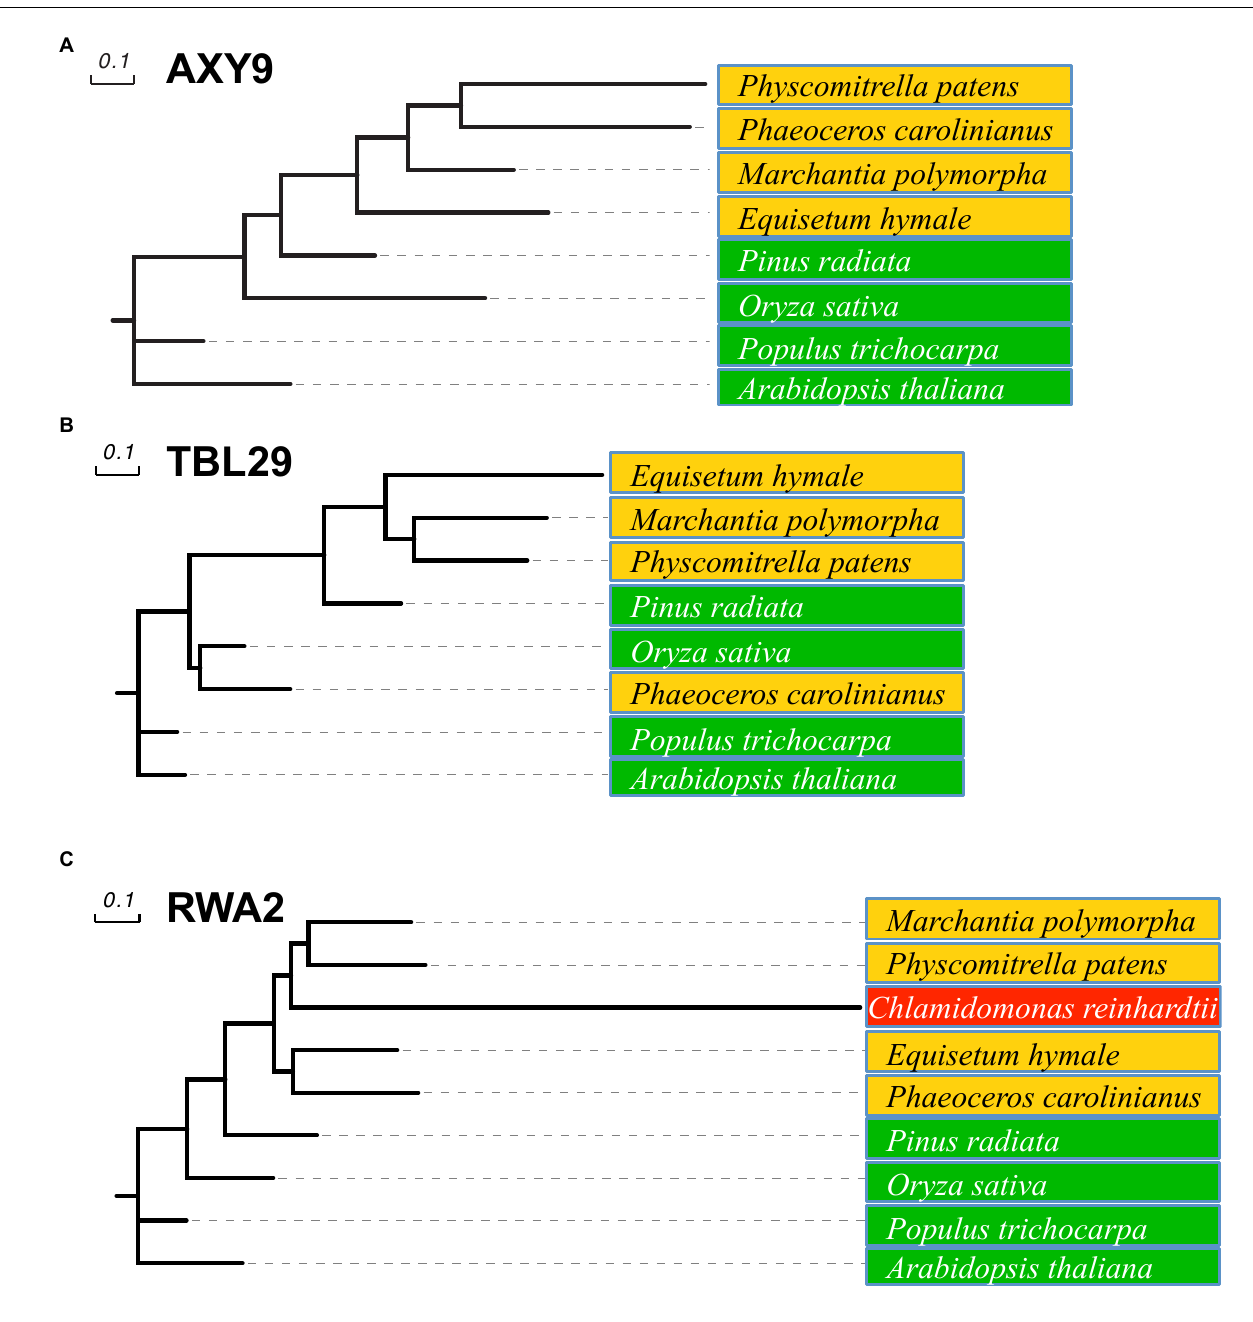
FIGURE 2 | Phylogenetic tree of AXY9, TBL, and RWA proteins. Likelihood tree of AXY9 (A) , TBL29 (B) , and RWA2 (C) protein homologs constructed from sequence alignment of selected species. Green: embryophytes ( Arabidopsis thaliana and Populus trichocarpa, dicots; Oryza sativa , monocot; and Pinus radiata , gymnosperm). Orange: Bryophyta ( Marchantia polymorpha , liverwort; Phaeoceros carolinianus , hornwort; and Physcomitrella patens , moss) and Pteridophyta ( Equisetum hyemale , horsetail). Red: Algae ( Chlamydomonas reinhardtii , green algae). Arabidopsis thaliana AXY9, TBL29, and RWA2 protein sequences